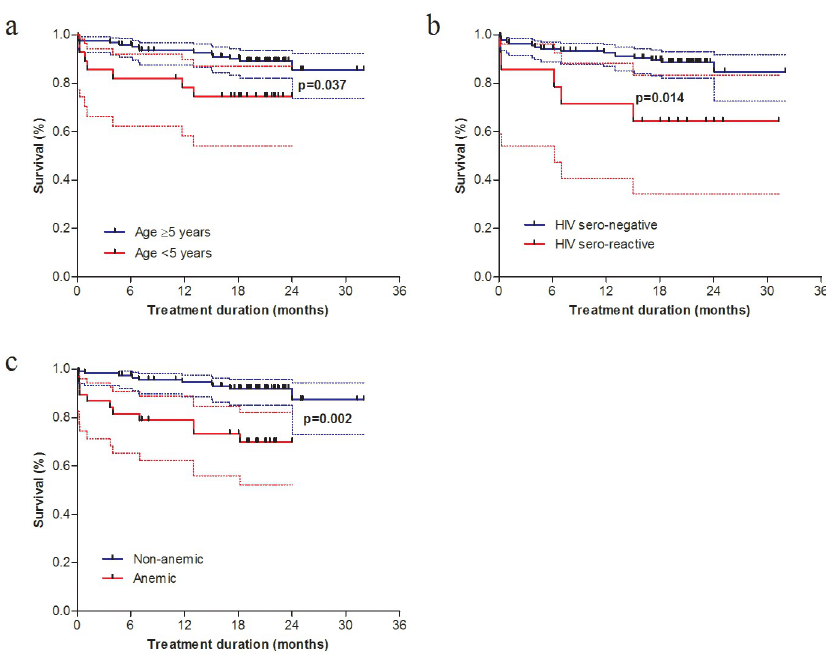
Fig 3. Kaplan-Meier survival curve for age category, HIV sero-status and hemoglobin category in children on DR-TB treatment (Dotted lines show 95% confidence interval).